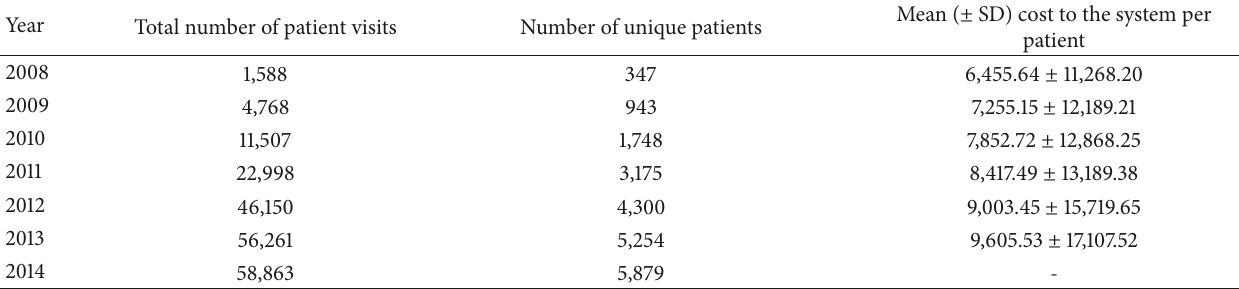
Table 2: Utilization of telemedicine for psychiatry and mean cost to the health care system.